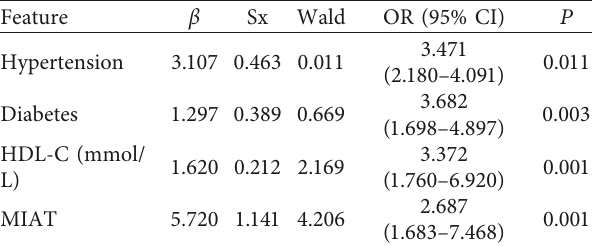
HDL-C: high-density